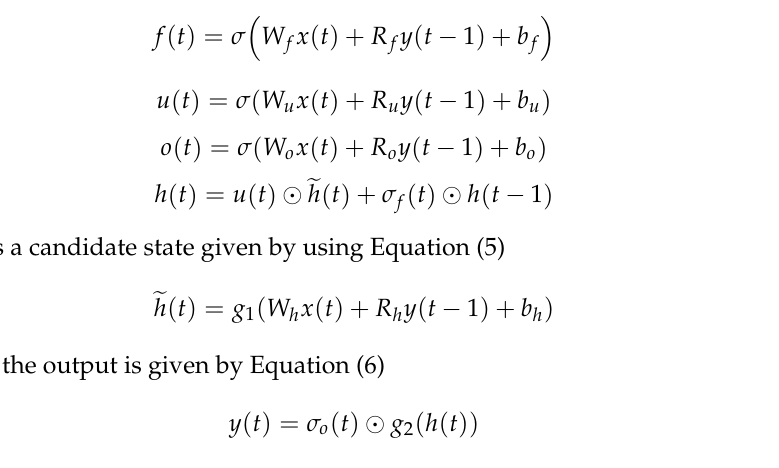
Figure 3. LSTM RNN Structure.